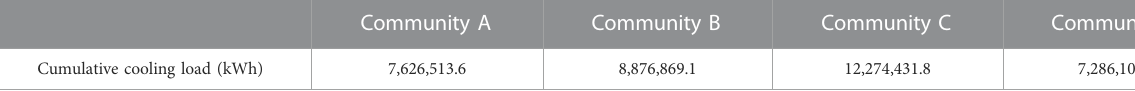
TABLE 8 Cumulative cooling load statistics table.